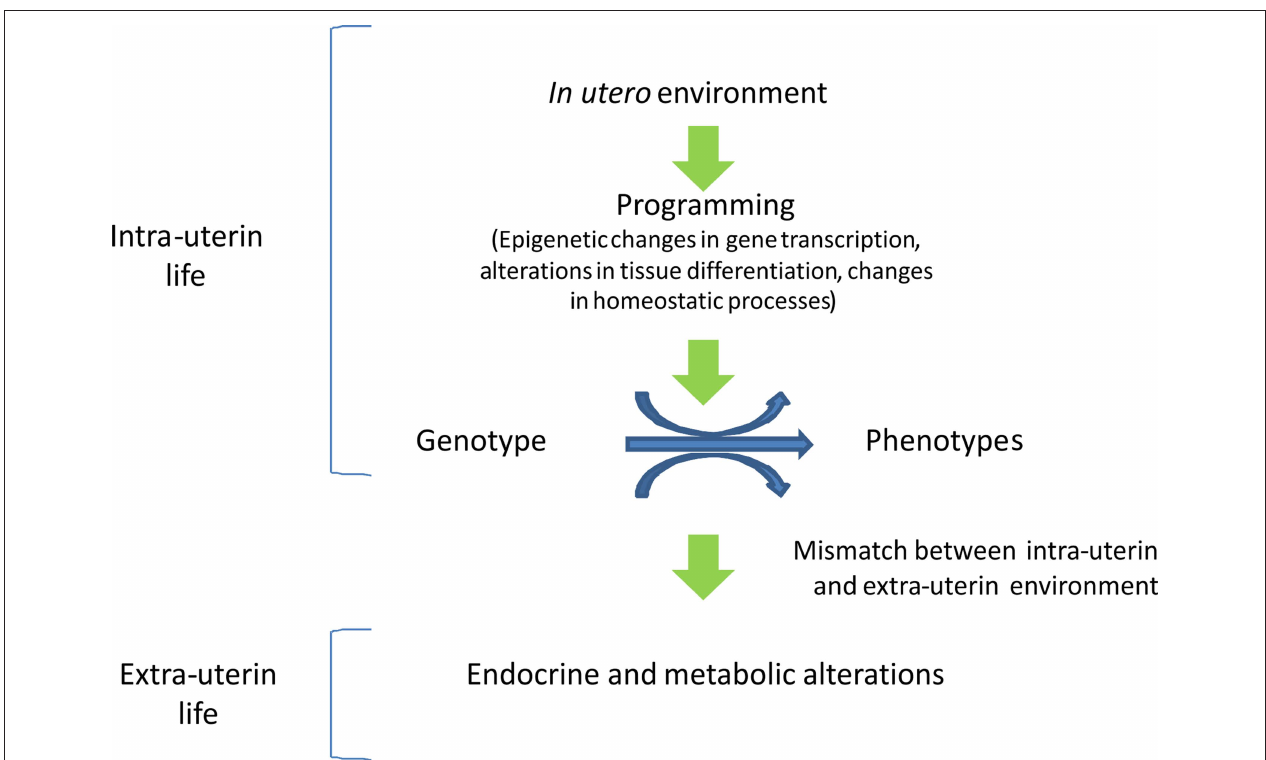
FigurE 2 | In utero epigenetic programming. Epigenetic programming permits a range of phenotypes to develop from a single genotype and is finalized to allow the organism to match its environment. When environmental conditions change a mismatch may occur, rendering the organism less adapt to cope to the new environment, eventually leading to